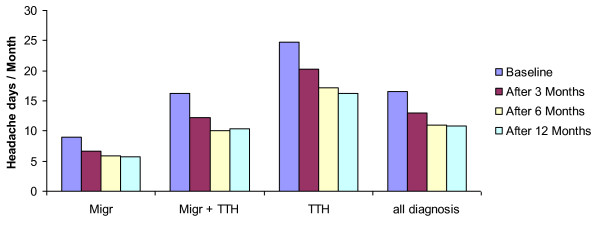
Course of headache days during one year. Reduction of headache days per month during one year, grouped for diagnosis and different dates of exploration. (Migr = migraine, TTH = tension-type headache)